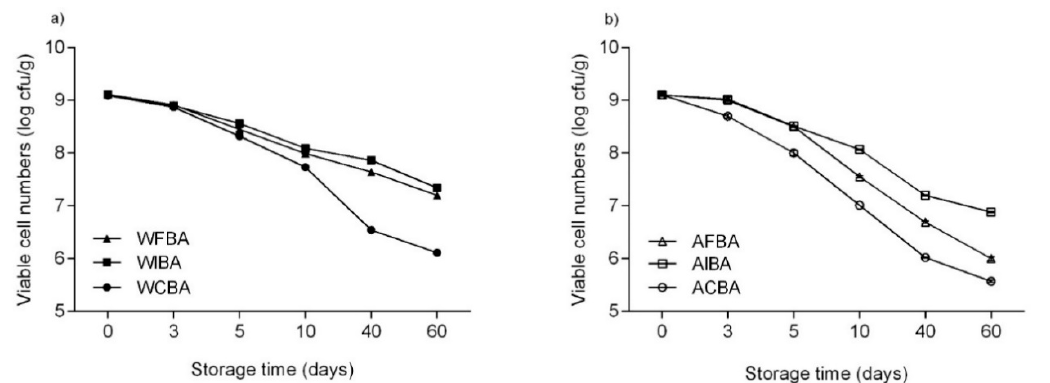
Figure 2. Survival of B. animalis subsp. lactis BB-12 during storage (60 days) at room (23 °C) temperature in ( a ) whey protein isolate (WPI)-based and ( b ) alginate (ALG)-based films with or without prebiotic incorporation. Each time point presented corresponds to the mean with standard deviation of the film samples analyzed ( n = 3).